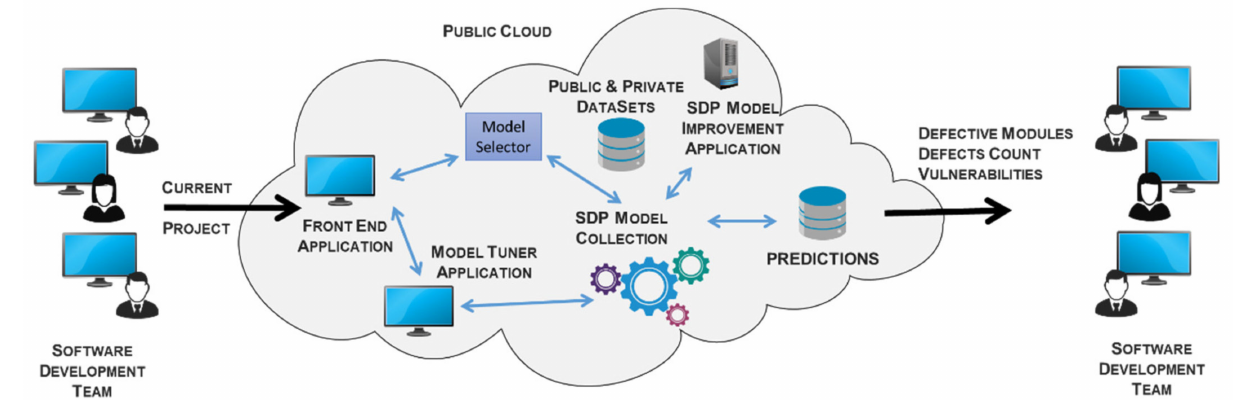
Figure 1. Functional diagram of